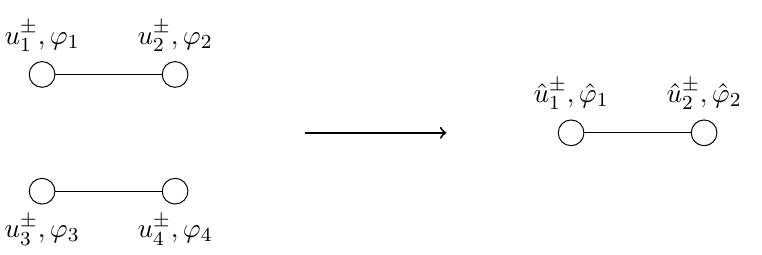
Figure 8 . Example of folding two “parallel” links which do not originate from the same node. Note that folding does not introduce a multiple link in this